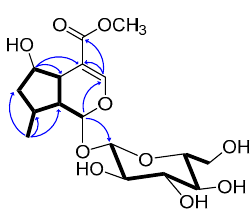
Figure 4. COSY connectivities (bold bonds) and key HMBC correlations (blue arrows) for nepetamoside ( 1 ).